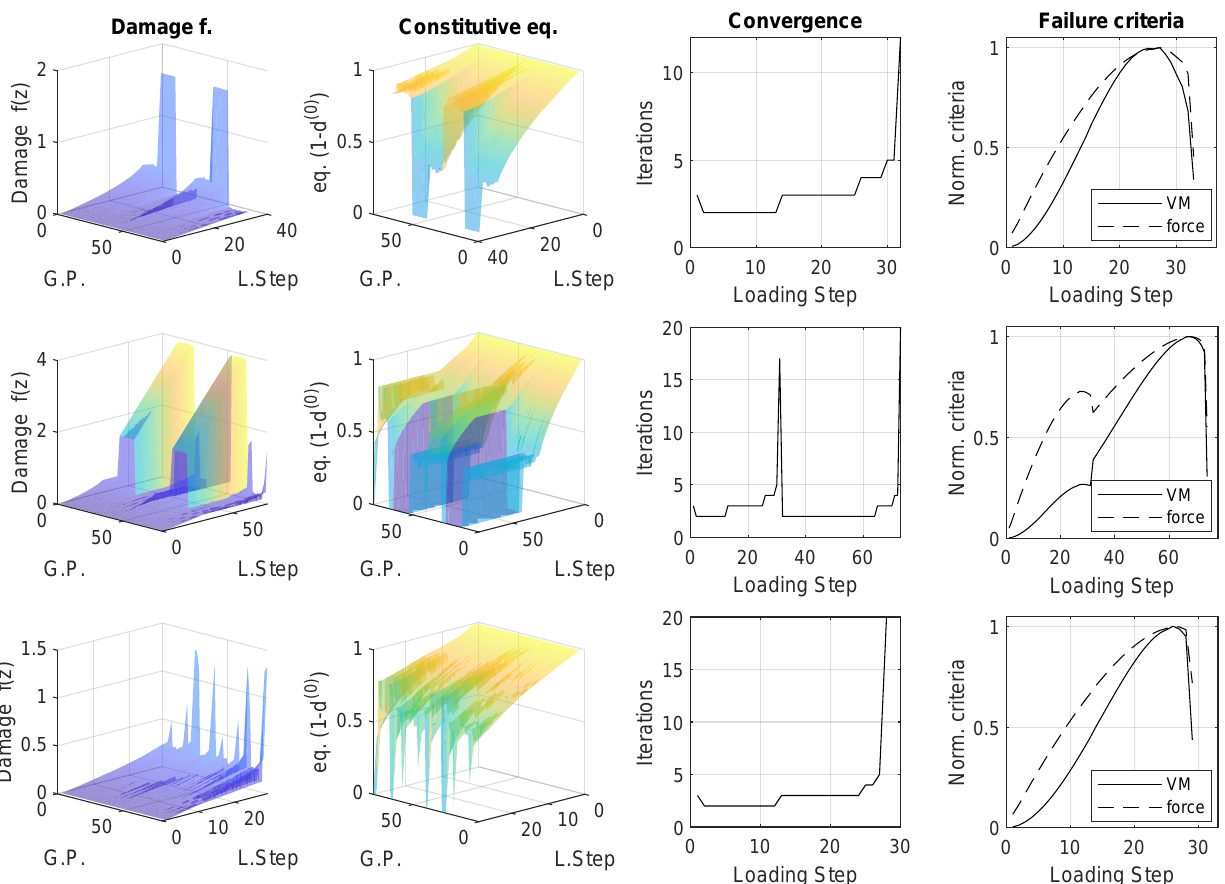
Figure 11. Stress ratio to peak failure criterion results. From top to bottom failure region 1 b , 2 b and 3 b . From left to right: damage parameter f ( z ) (Equation (8)), constitutive equation affecting Gauss Points ( 1 − d ( 0 ) ) (Equation (7)), iterations for convergence of the nonlinear problem at each loading step and normalized failure criteria (von Misses and Stress